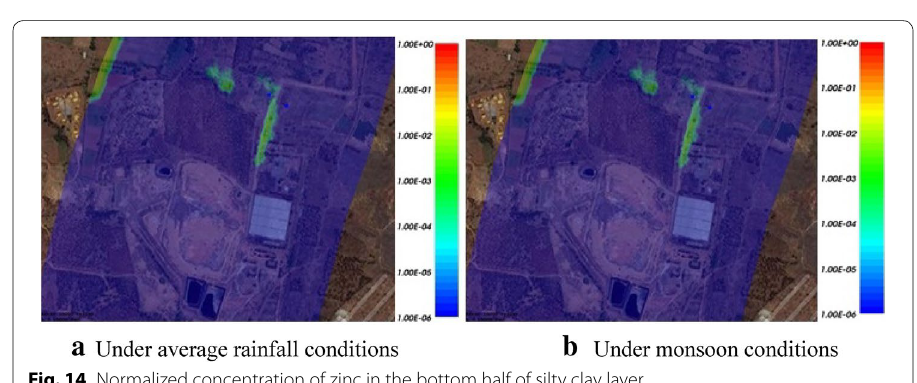
bodies. While for the pond (the blue dot towards north-west), the pollutant reaches merely by means of advection, for the well (the blue dot towards southeast), its pollu- after the building cover such that crosswind diffusion is free to take place and achieve maximum dispersion. The distribution of zinc and iron in the various layers, under average rainfall and monsoon conditions, is shown in the Figs. 12, 13, 14, 15, 16, 17,